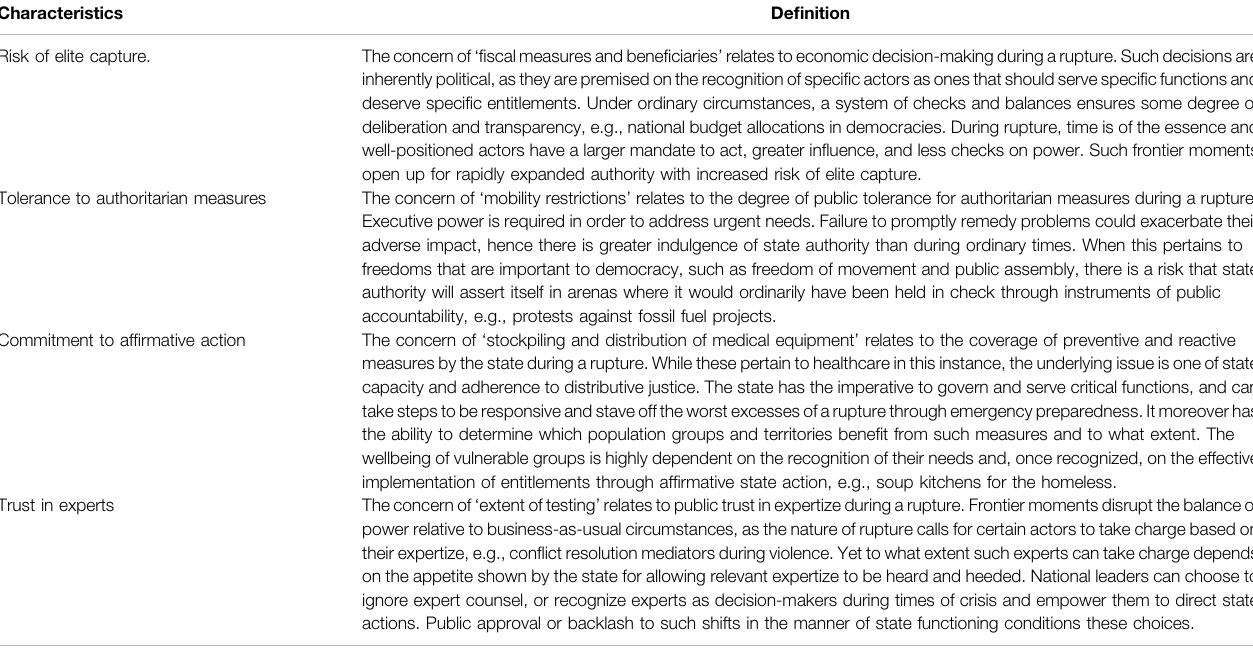
TABLE 2 | State characteristics relevant to the four pandemic response related concerns.